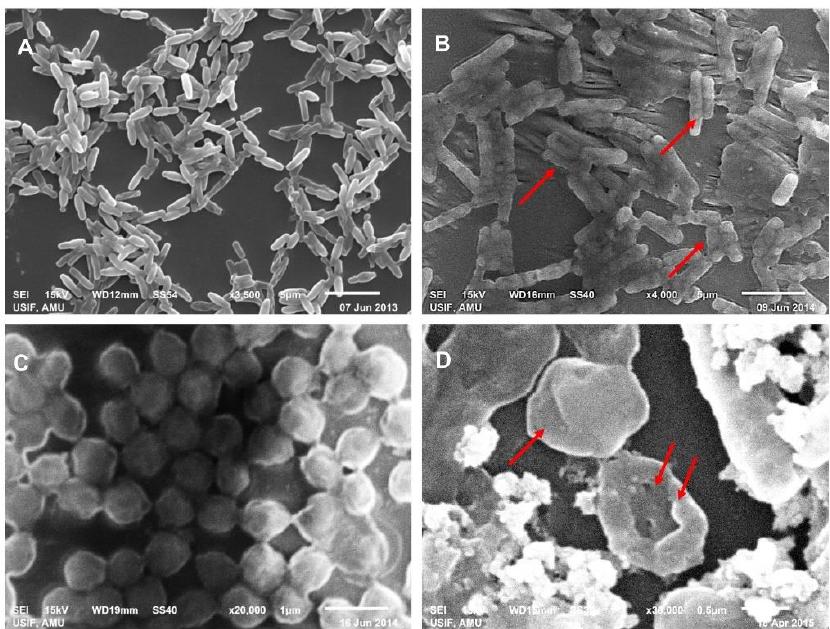
Figure 7. Ultrastructural analysis showing interaction of CLE-CuONPs with bacterial cells. Representative SEM images showing the cellular damage and surface binding of CLE-CuONPs with ( B ) E. coli -336 and ( D ) MRSA-1. The images in ( A ) and ( C ) show the untreated controls of E. coli- 336, and MRSA-1.